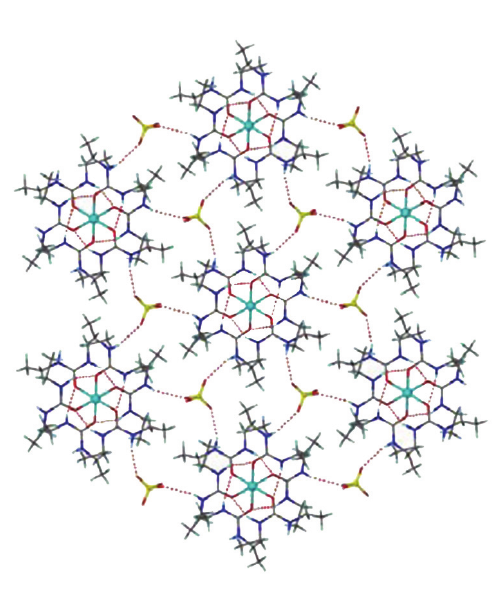
† Symmetry transformation used to generate equivalent atoms: a − x , − y , − z ; b x , y , 1 + z ; c 1 − x , 1 − y , − z . ‡ D = donor atom. § A = acceptor atom.